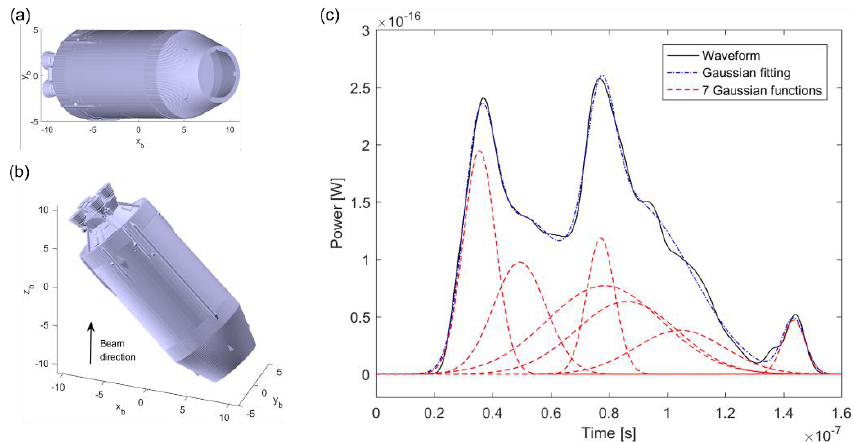
Figure 12. The ( a ) reflected surface, ( b ) orientation of rocket body, and ( c ) the echo waveform and 7 Gaussian functions obtained from the Gaussian decomposition for 45° rotation about the y-axis w.r.t. Figure 2b.